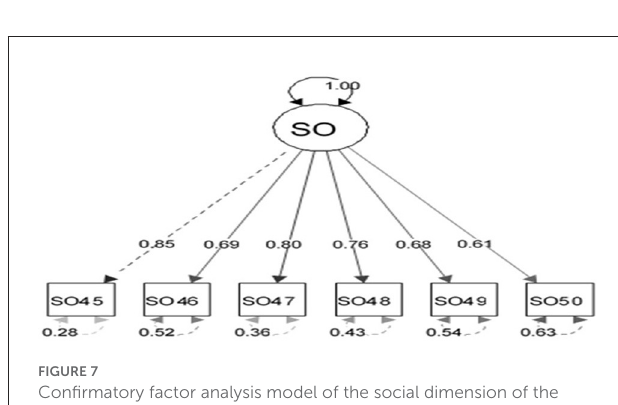
FIGURE6 Confirmatory factor analysis model of the questionnaire on the technology dimension of the family support for older people questionnaire. All items in the questionnaire showed a factor load > 0.3, indicating appropriate metrics for the tool factor.